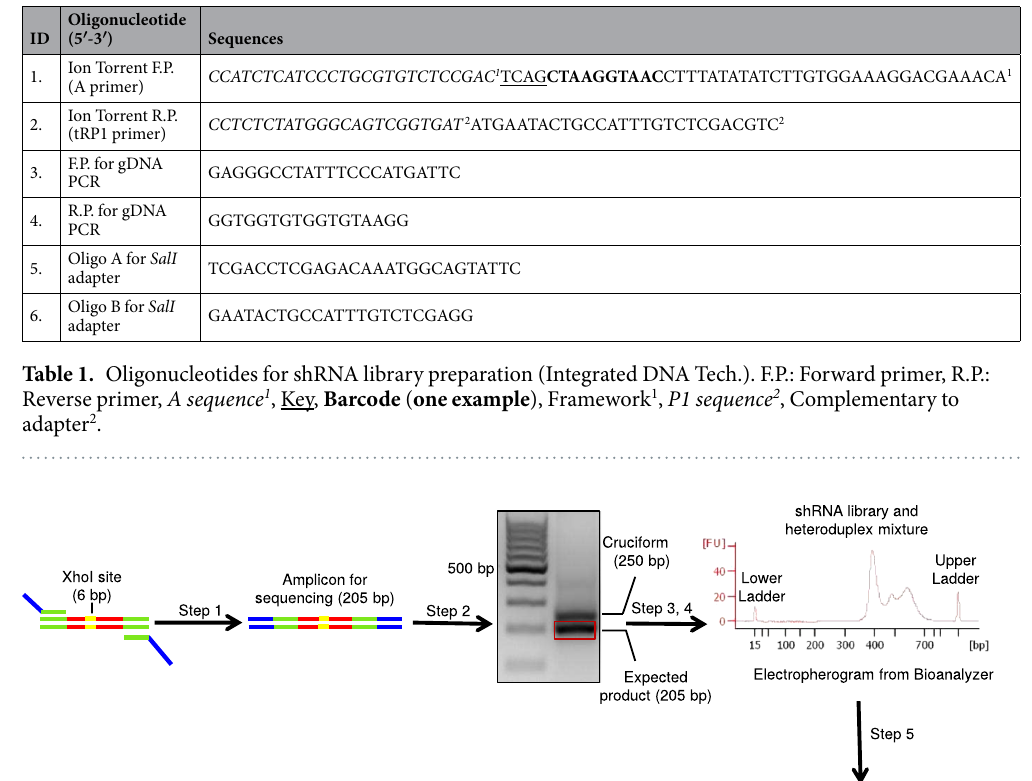
to 800 µ l. The entire 800 µ l was divided into 16 reactions with each reaction as a 50 µ l aliquot and PCR was done using a Thermal Cycler (Applied Biosystems). The temperature profile for the PCR was set as, 3 min at 98 °C, 30 cycles of amplification (10 sec at 98 °C, 15 sec at 55 °C, 15 sec at 72 °C) and 5 min at 72 °C. We used 20 µ g template to ensure enough representation of each shRNA from the library during the amplification. PCR reactions were pooled together and purified using the GeneJET PCR Purification Kit (Thermo Scientific) according to manufac- turer’s protocol and eluted in 100 µ l DNAase-free ddH 2 O. DNA concentration and purity were quantified using NanoDrop ™ 2000/2000c. A small sample (2 µ l) of the PCR product (with 6X DNA Gel Loading Dye, Thermo Scientific) was run at 90 V for 45 minutes in a Gel Electrophoresis Apparatus (Bio-Rad) using a 2% UltraPure ™ Agarose gel (Thermo Scientific) stained with SYBR ® Safe DNA Gel Stain (Thermo Scientific) in 1X TAE (Thermo Scientific). The 205 bp (shRNA sequencing) and 359 bp (half-shRNA sequencing) expected bands were detected on Gel Doc ™ XR + Imager (Bio-Rad) using 100 bp DNA Ladder (Thermo Scientific) (Figs 2 and 3). About, 2 µ g of the 205 bp product was resolved (with 6X DNA Gel Loading Dye) at 90 V for 45 minutes in a Gel Electrophoresis Apparatus using 2% low-melting UltraPure ™ Agarose (Thermo Scientific) and the gel was stained with SYBR ®